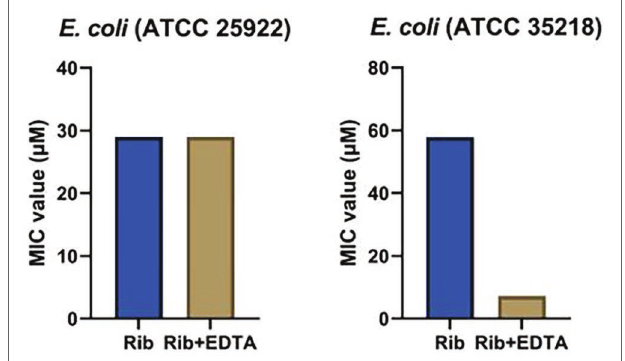
FIGURE 4 | Minimum inhibitory concentration (MIC) values of ribostamycin co-treatment with ethylenediaminetetraacetic acid (EDTA) against Es. coli strains.